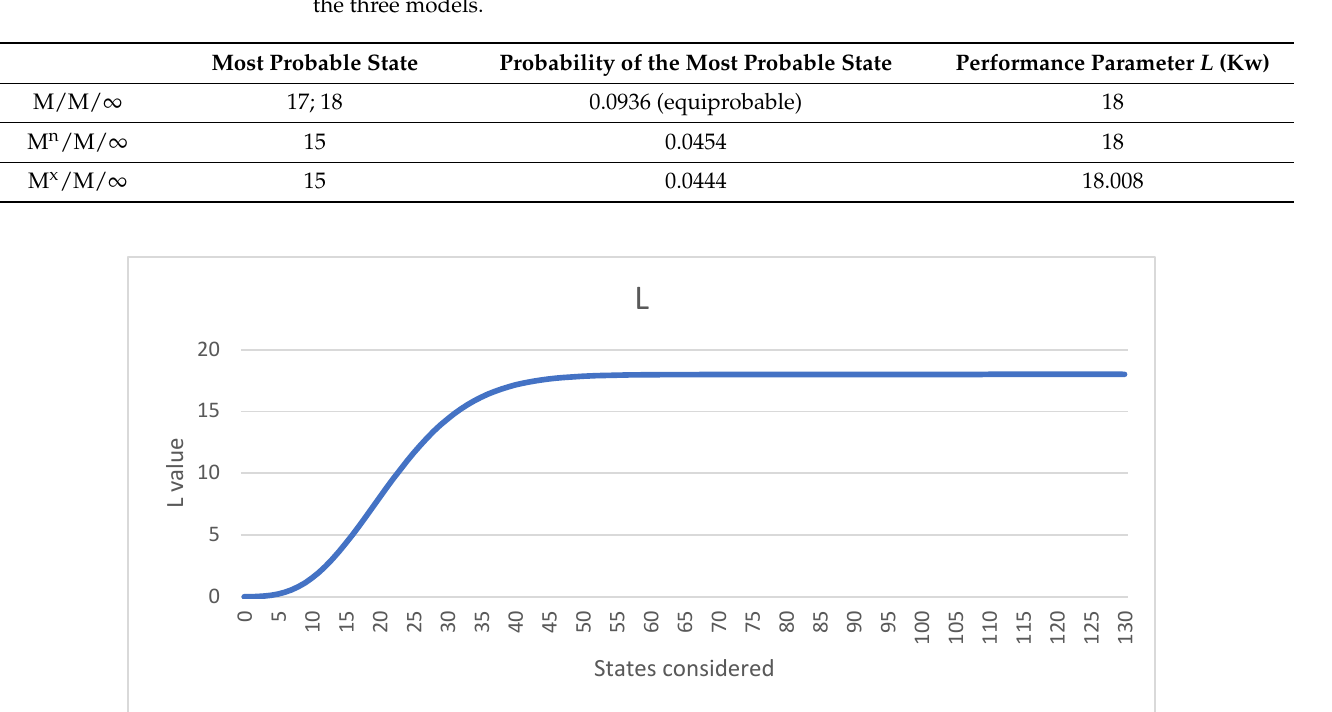
Figure 4. Stabilisation in the calculation of parameter L .